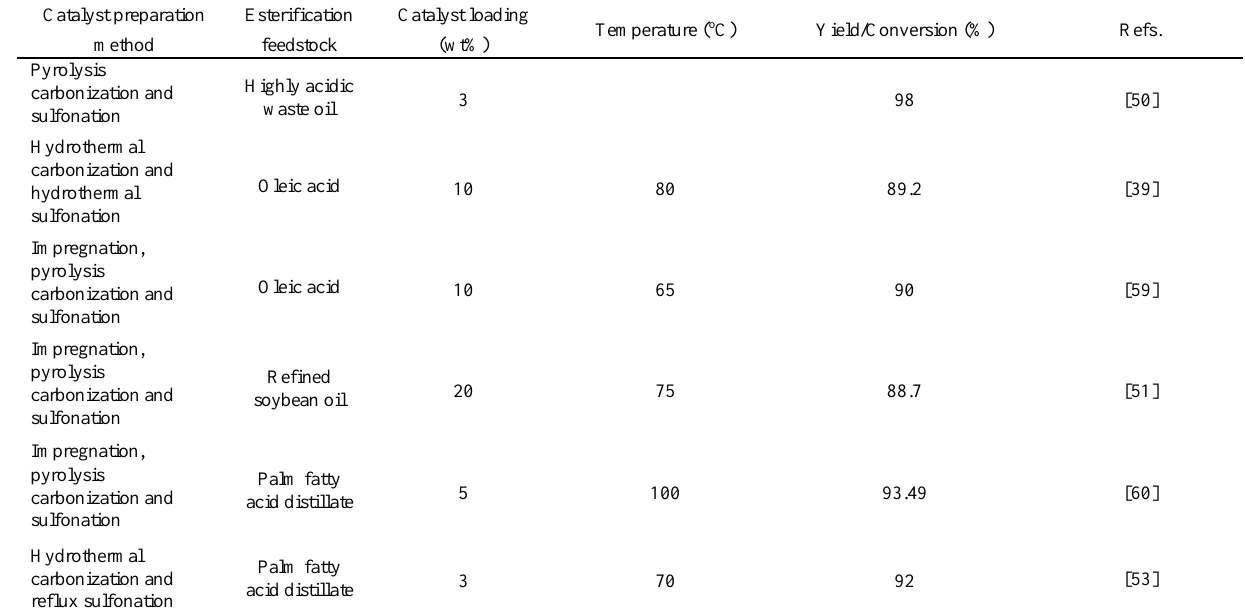
Table 1. A literature report on biodiesel production over corncob-derived solid acid